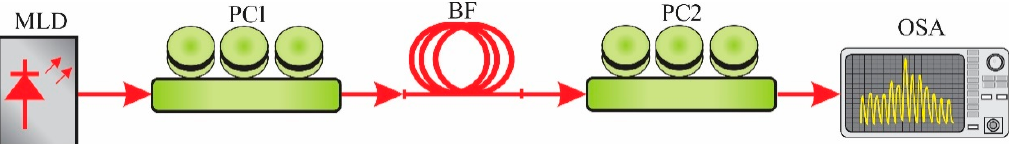
Figure 1. Schematic diagram of an optical filter. MLD: multimode laser diode; PC: polarization Figure1. Schematicdiagramofanopticalfilter. MLD:multimodelaserdiode;PC: polarization controller; controller; BOF: birefringent optical fiber; OSA: optical spectrum analyzer [9]. BOF: birefringent optical fiber; OSA: optical spectrum analyzer